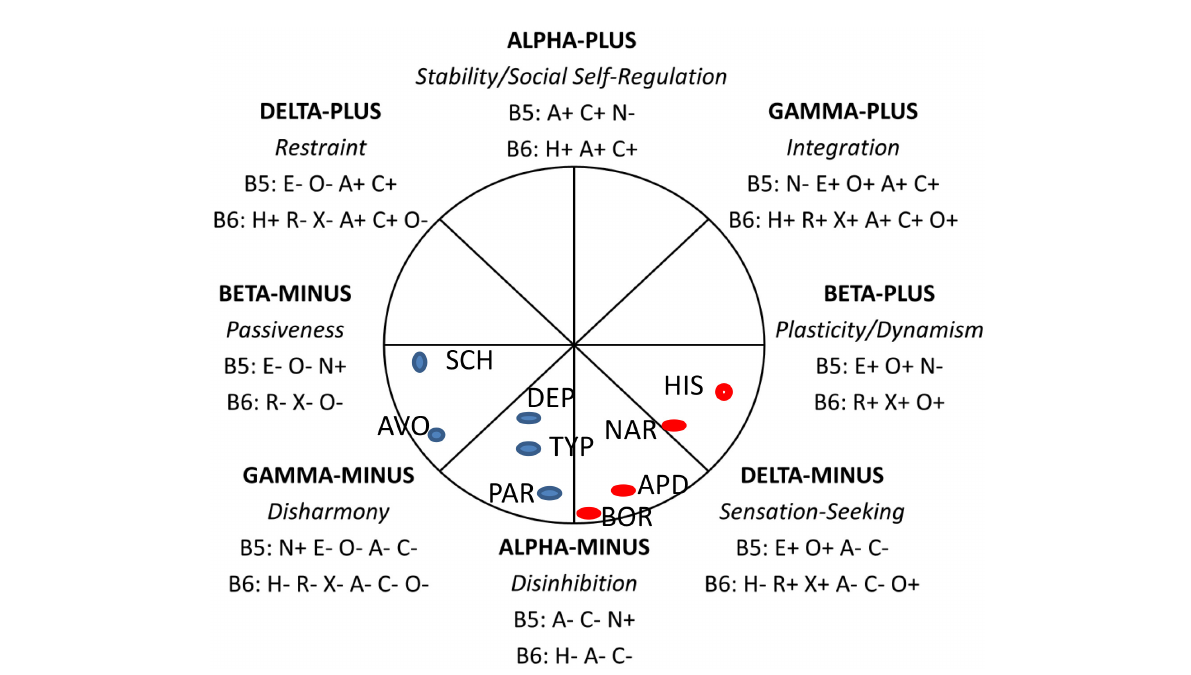
FIGURE1 The circumplex of personality metatraits. B5, Big Five traits: N, Neuroticism/Emotional Stability; E, Extraversion; O, Openness to Experience/Intellect; A, Agreeableness; C, Conscientiousness. B6, Big Six traits: H, Honesty-Humility/Propriety; R, Resiliency/Emotionality; X, Extraversion; A, Agreeableness; C, Conscientiousness; O, Originality/Openness to Experience. +, positive pole of the trait; –, negative pole of the trait. The approximate positions of PDs, as reported by Zawadzki (8), are indicated by blue and red circles: SCH, Schizoid PD; AVO, Avoidant PD; DEP, Dependent PD; TYP, Schizotypal PD; PAR, Paranoid PD; BOR, Borderline PD; APD, Antisocial PD; NAR, Narcissistic PD; HIS, Histrionic PD. The figure is based on Strus and Cieciuch (26) and reprinted with